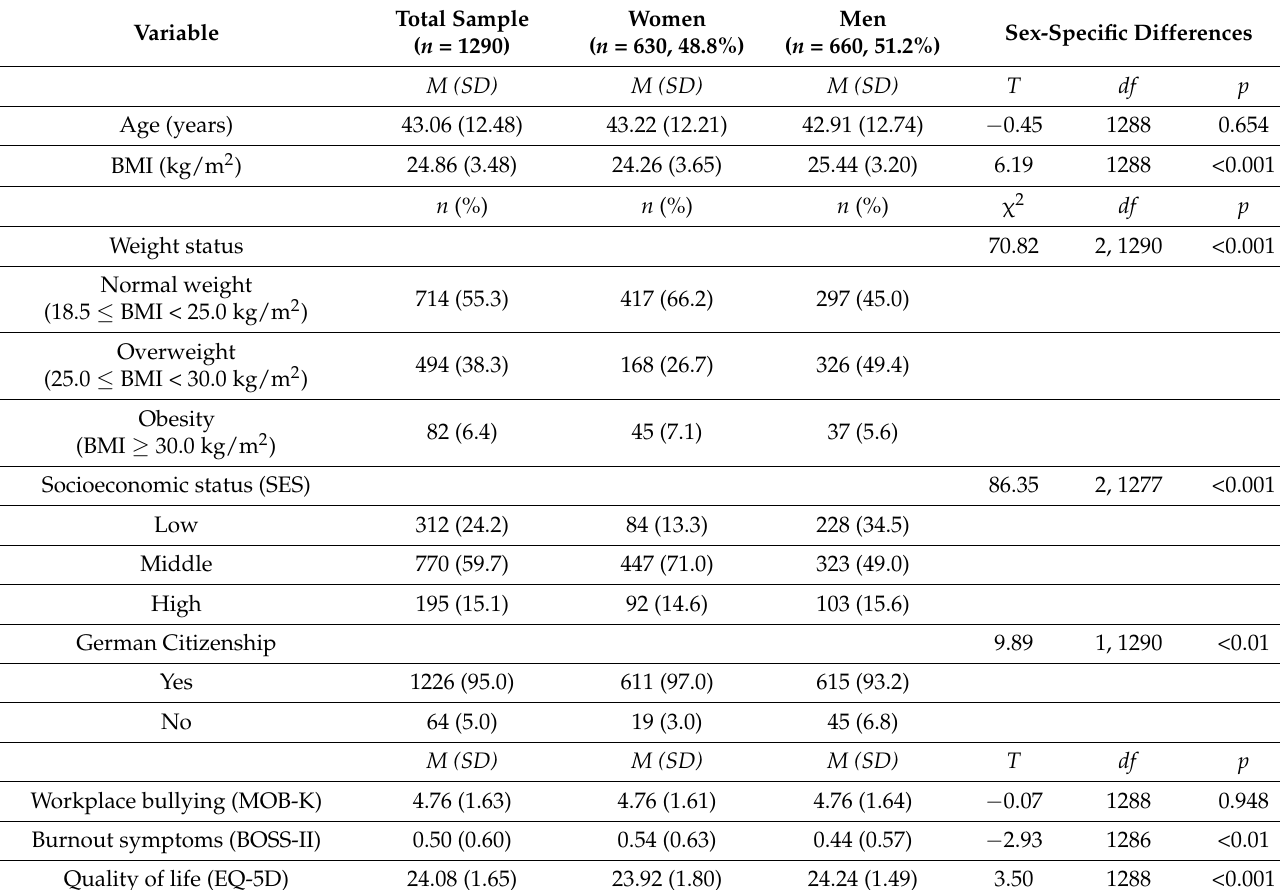
Table 1. Sociodemographic and clinical variables for the total sample and sex-specific subsamples, including sex-specific differences using t -tests for continuous and χ 2 -tests for categorical